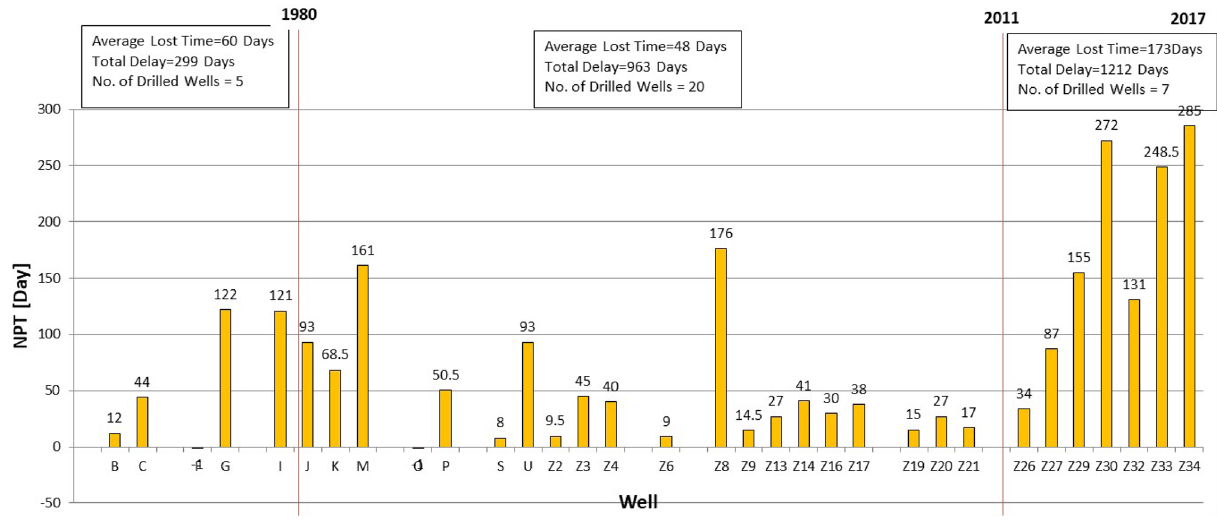
Fig. 5 Drilling delays/time deviations (for 32 wells in Kupal field)